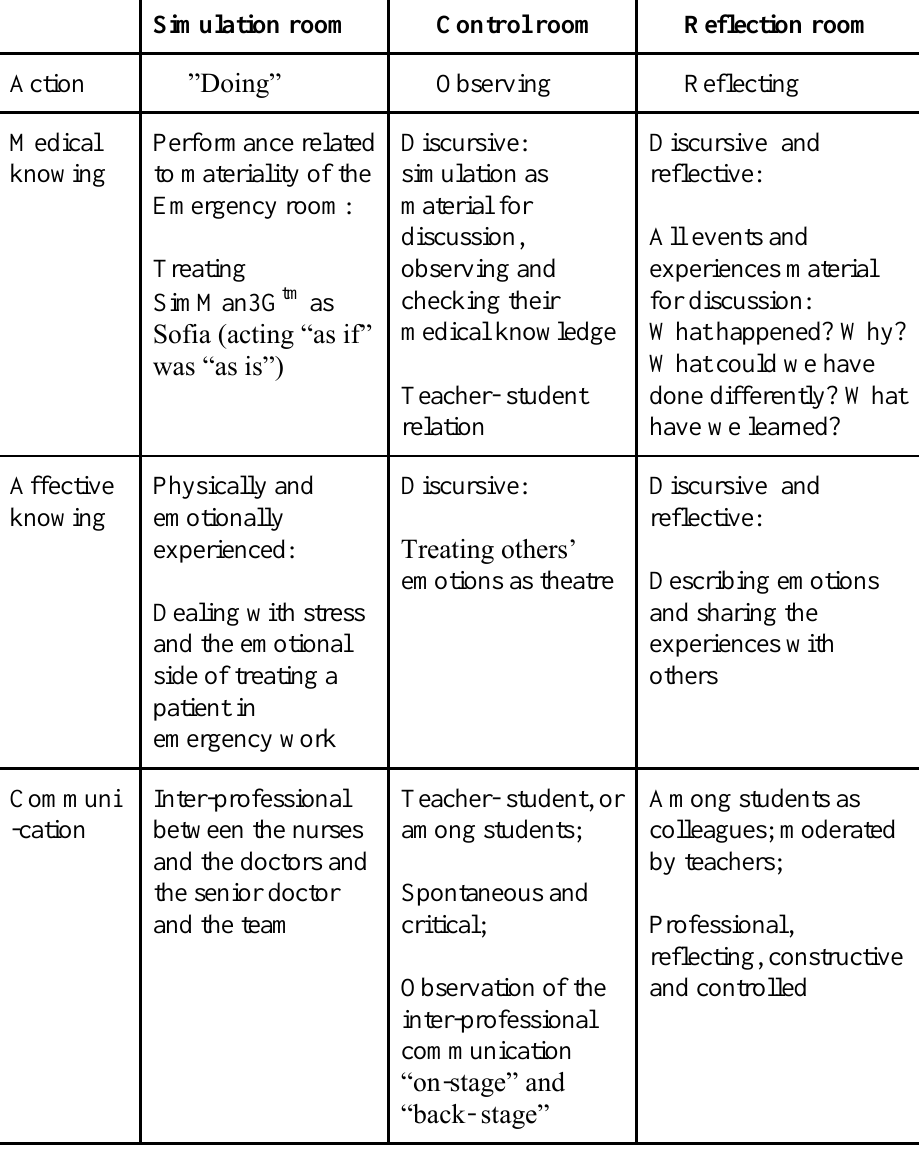
Table 2 Different locations and